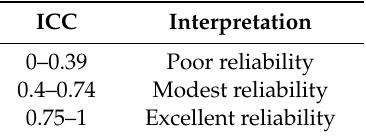
Table 4. Intra-class correlation coe ffi cient (ICC) values interpretation